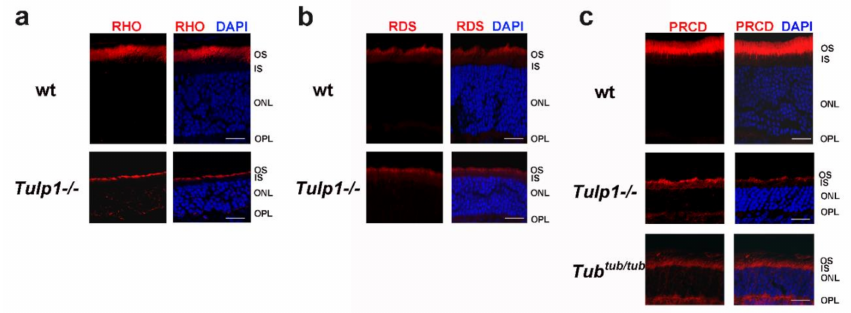
Figure 5. PRCD is mislocalized in photoreceptors of Tulp1 - / - and Tub tub / tub mice. ( a ) Immunostaining of retinal sections derived from wt and Tulp1 - / - mice, with an antibody against rhodopsin (RHO) (red). ( b ) Immunostaining of retinal sections derived from wt and Tulp1 - / - mice, with an antibody against peripherin / RDS (red). ( c ) Immunostaining of retinal sections derived from wt, Tulp1 - / - , and Tub tub / tub mice, with an antibody against PRCD (red). DAPI served for nuclear staining (blue). scale bars: 20 µ m. IS, inner segment; ONL, outer nuclear layer; OPL, outer plexiform layer; OS, outer